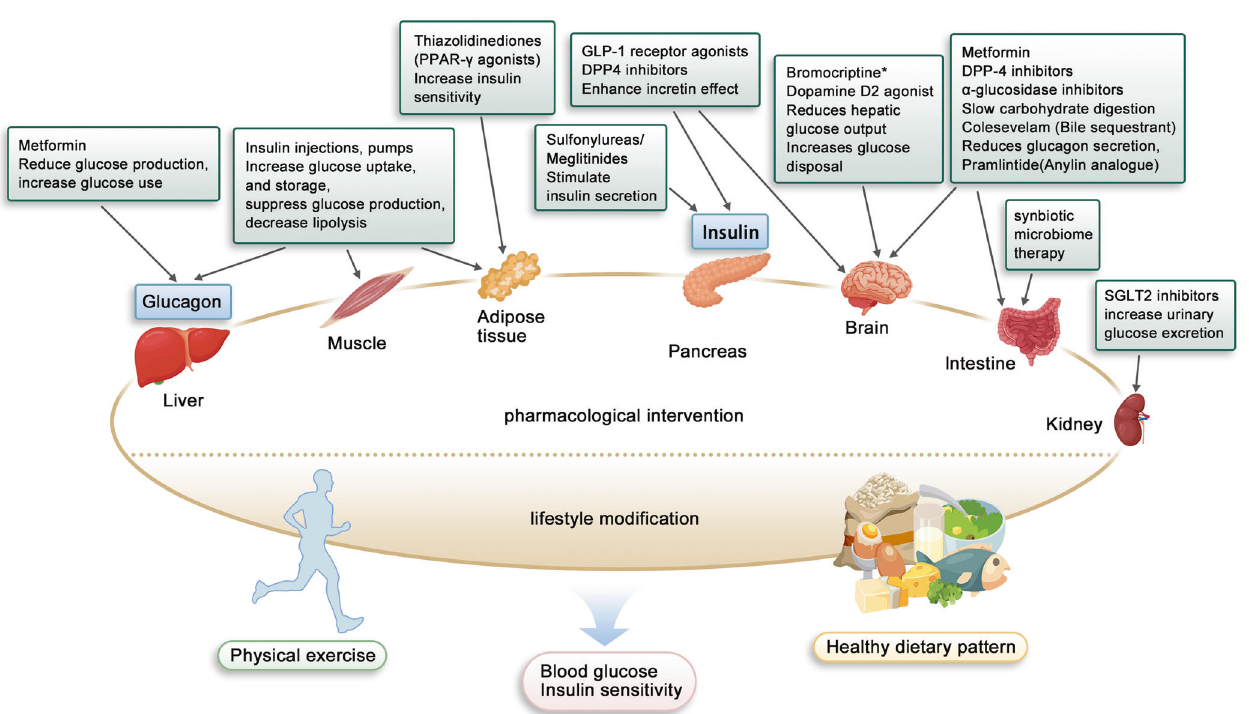
Fig. 6 Therapeutic strategy of insulin resistance Signal Transduction and Targeted Therapy (2022)